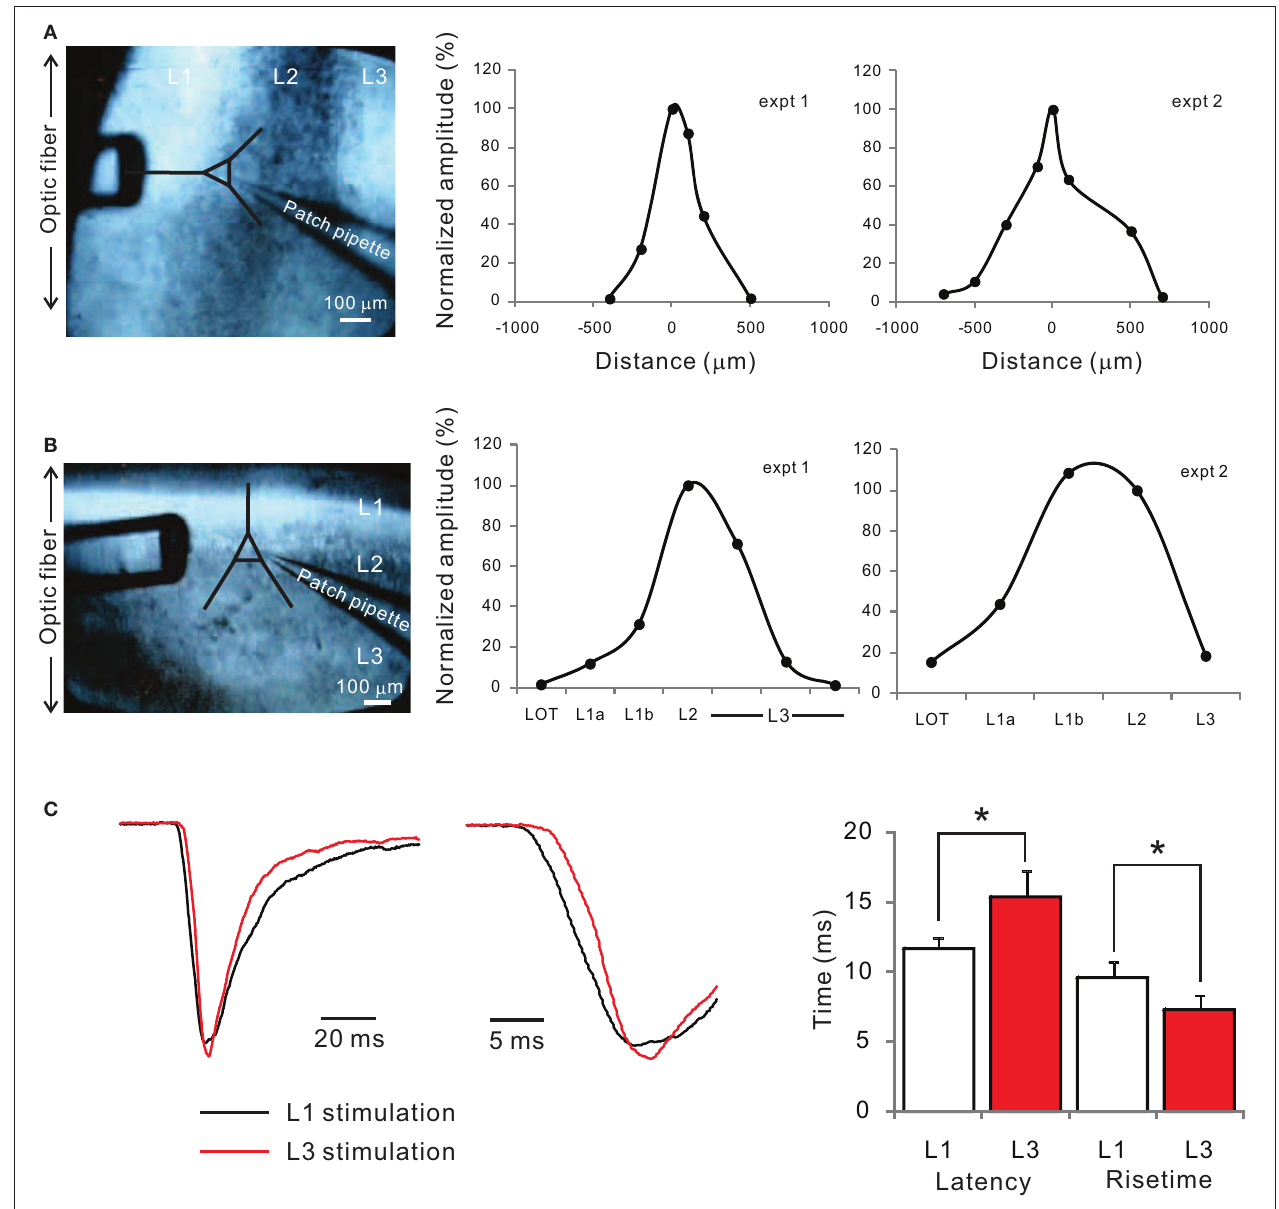
FIGURE A3 | Local stimulation with multimode optic fiber. Focal stimulation of ChR2-expressing axons was performed by coupling a blue laser (GLG 3080B, NEC Inc., emitting approximately 5mW) onto one end of a 50 µ m core, 0.22 NA multimode optic fiber (M14L05, Thorlabs Inc.). The other end was cleaved and threaded through a 25G stainless steel needle (6937A28, McMaster-Carr Inc.) and epoxied to create a makeshift stimulating optrode. Timing of stimulation was controlled by a shutter (Uniblitz VS25S2ZM1, Vincent Associates Inc.) and shutter driver (Uniblitz T132, Vincent Associates Inc.) in the light path between the laser and the fiber. We isolated monosynaptic excitatory inputs from ChR2-expressing axons using